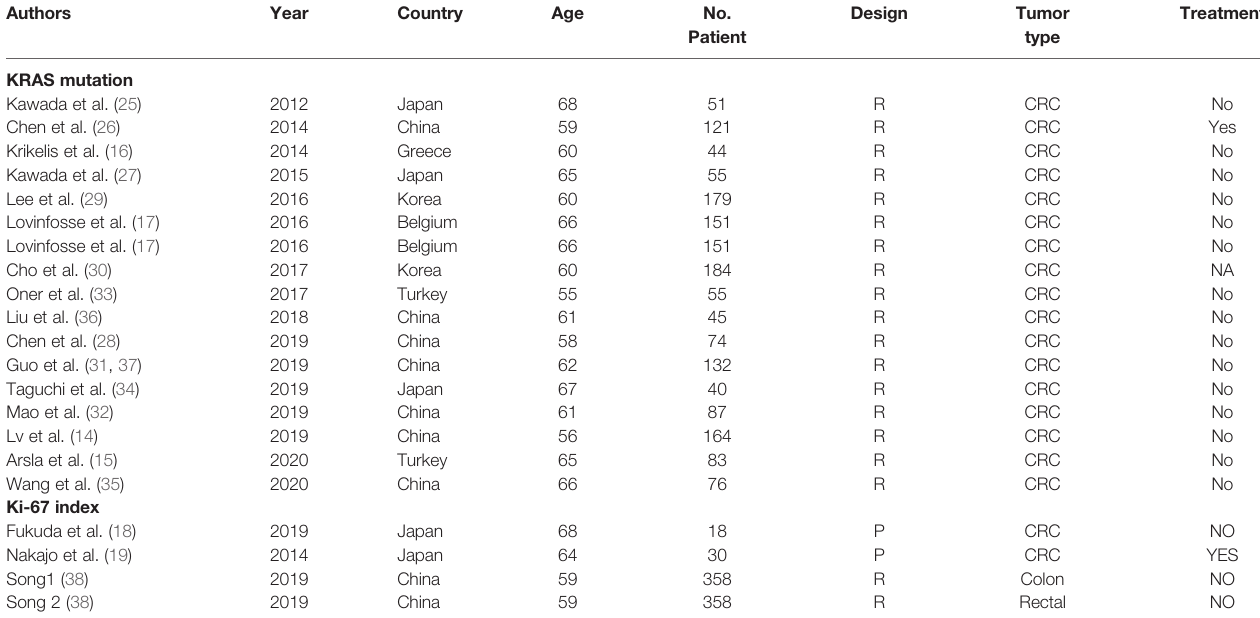
TABLE 3 | Characteristics of studies analyzed the association of SUVmax with KRAS and Ki-67 in colorectal cancer.